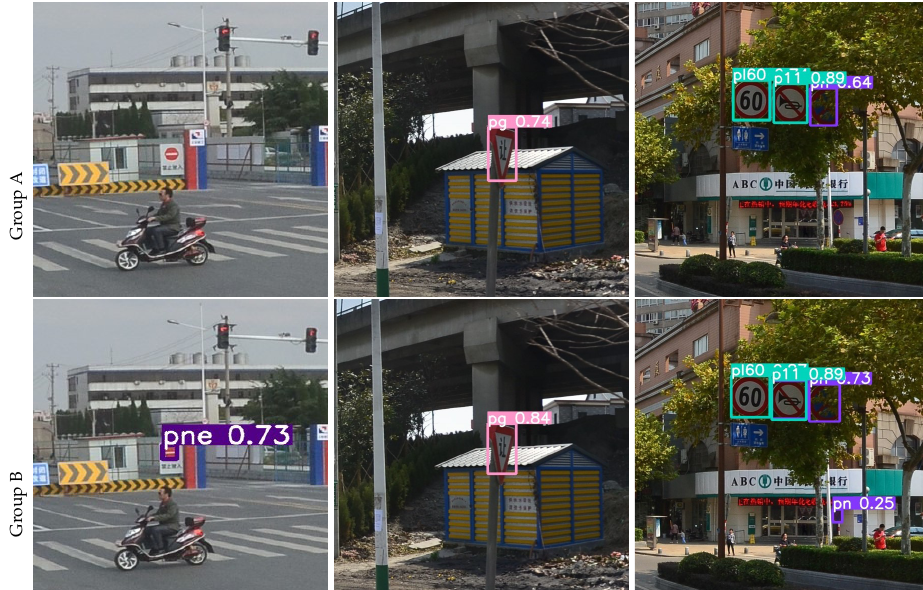
Figure 8. Detection in daytime scenes. The left column shows the missed detection; the middle column is deformed traffic sign detection; and the right column is occlusion traffic sign detection.